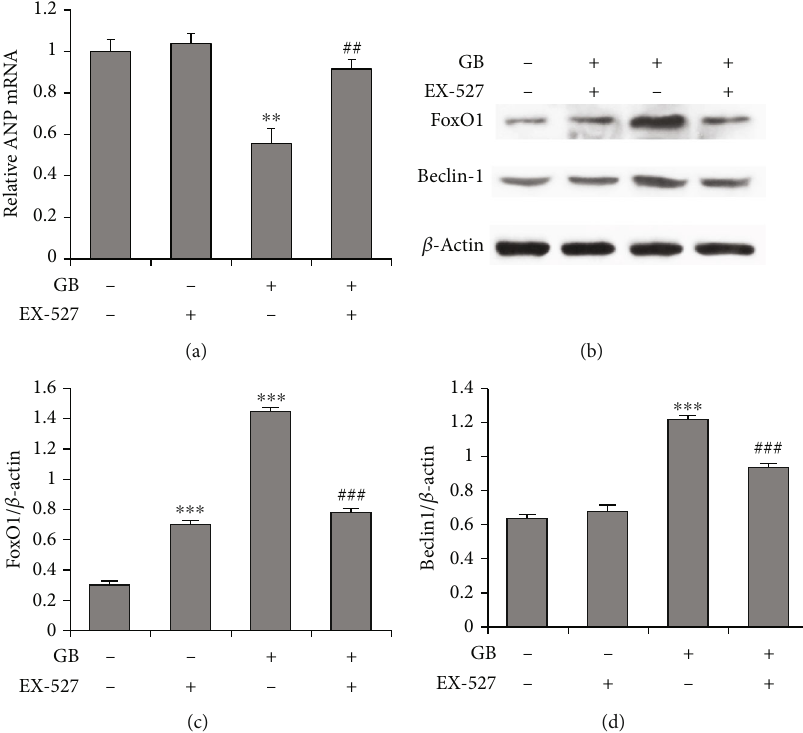
Figure 4: SIRT1 mediates the protective e ff ects of Ginkgolide B on Ang II-induced hypertrophy in cardiomyocytes. H9c2 cells were pretreated with Ginkgolide B (30 μ M) and SIRT1 inhibitor, EX-527 (100nM), for 2 h and then incubated with Ang II (1 μ M) for further 48h. (a) ANP mRNA level after SIRT1 inhibition. (b) Representative blots of SIRT1 and autophagy-related proteins. EX-527 abolishes Ginkgolide B ’ s promotive e ff ect on (c) FoxO1 and (d) Beclin-1 protein expressions. ∗∗ P < 0 : 01 , ∗∗∗ P < 0 : 001 vs. the GB group; ### P ≤ 0 : 001 vs. the EX-527